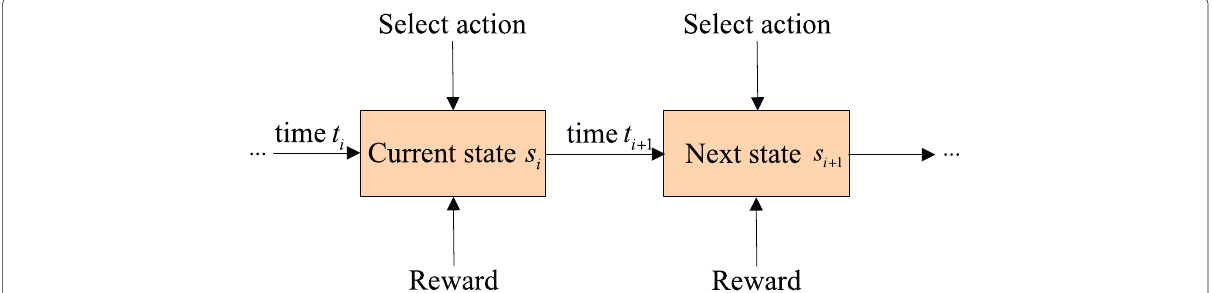
Fig. 3 The decision process of the admission controller. The decision process of the admission controller is represented as the process shown in this figure. The decision-making process will go on in this form and generate a policy made up of state-action pairs and a reward